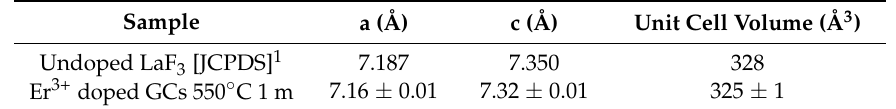
Table 1. Lattice constants of 80SiO 2 -20LaF 3 -0.5Er 3+ (TEOS-MTES) glass-ceramic bulk sample treated at 550 ◦ C for 1 min.